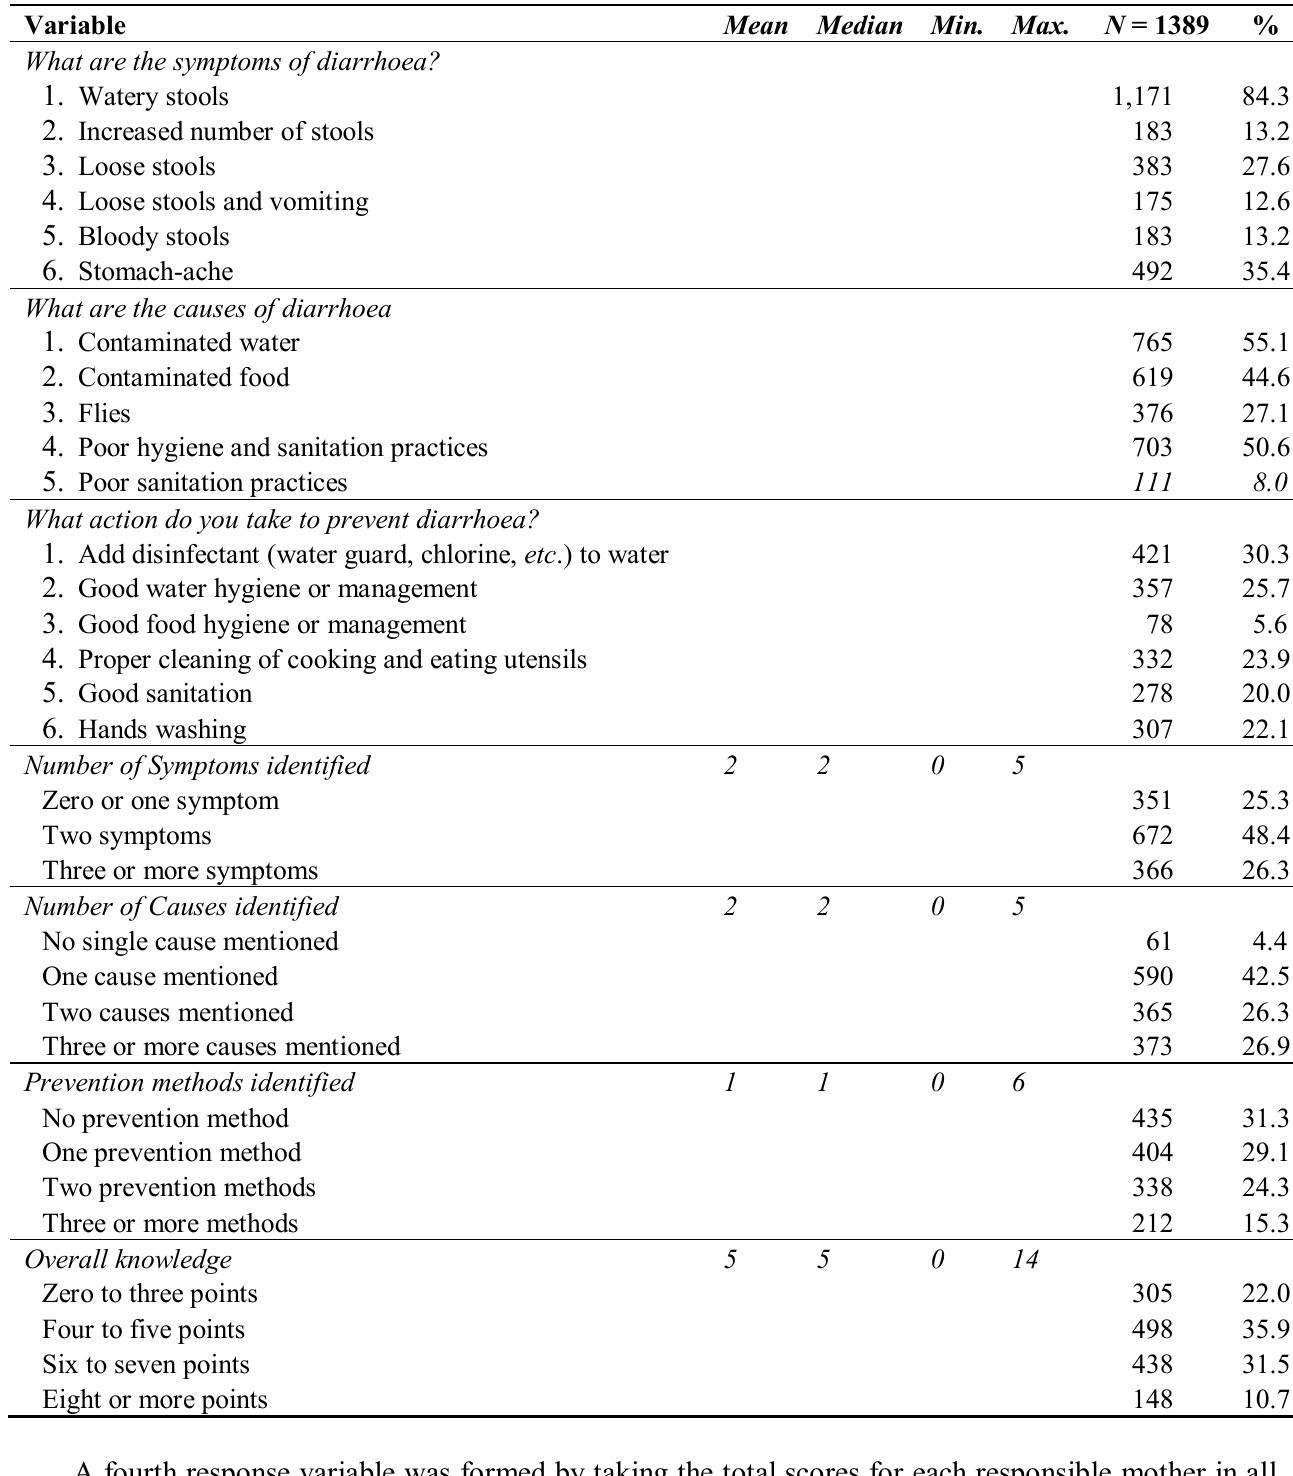
Table 1. Descriptive statistics for response variables on diarrhoea